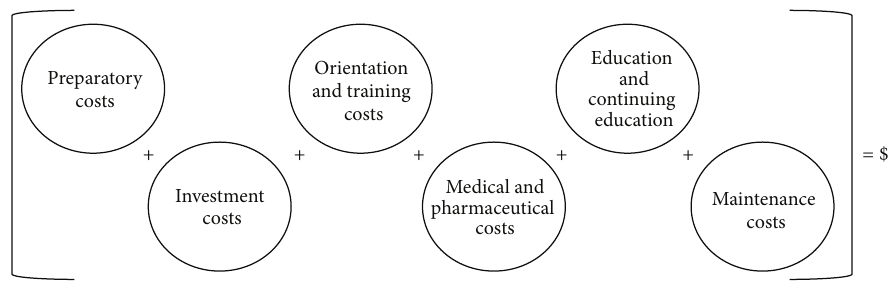
Figure 1: Basic model for cost